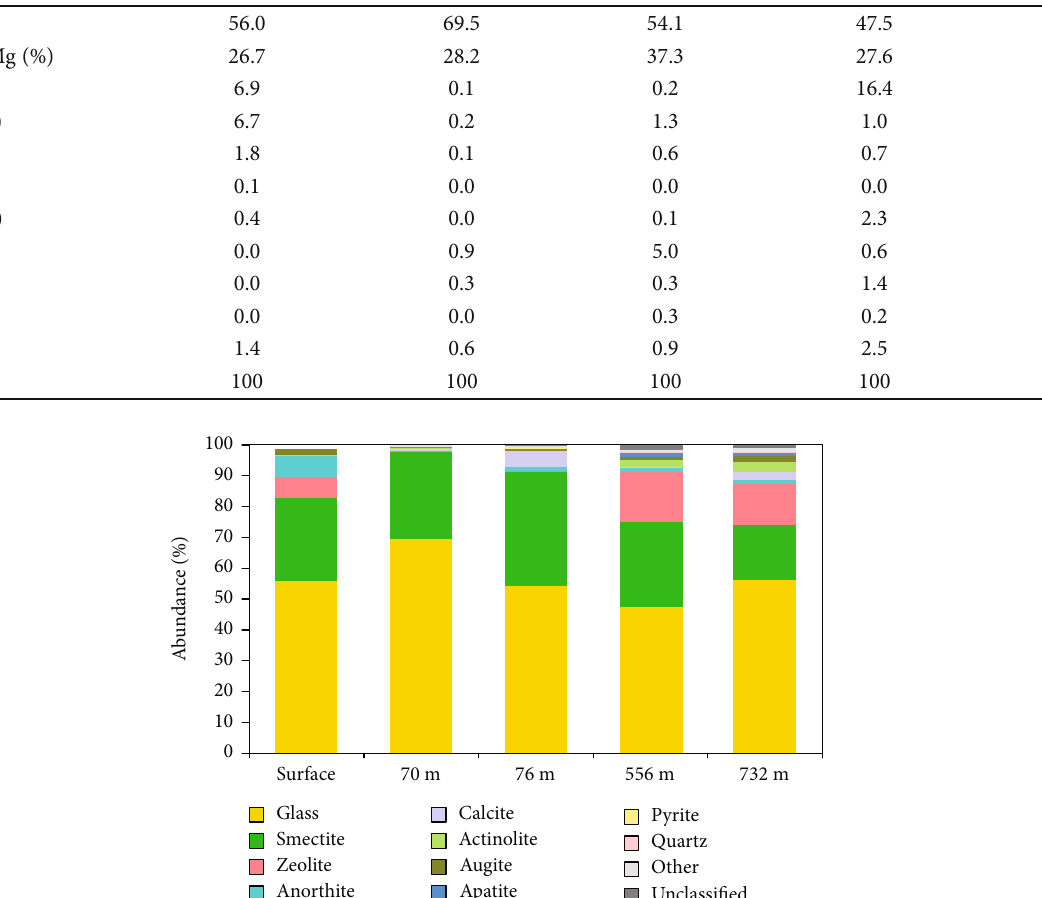
Figure 5: Phase abundance histogram for hyaloclastite from di ff erent depths within the hydrothermal reservoir at Kra fl a volcano, NE Iceland, from SEM-EDS QEMSCAN® maps with 20µm step size (Figure 3). The most abundant phase is glass for all samples, i.e., surface, 70 m, 76 m, 556m, and 732m depth. Other represents other identi fi ed phases present in trace amounts; unclassi fi ed represents those uncategorised, which may be due to very fi ne grain sizes (whereby each pixel represents multiple